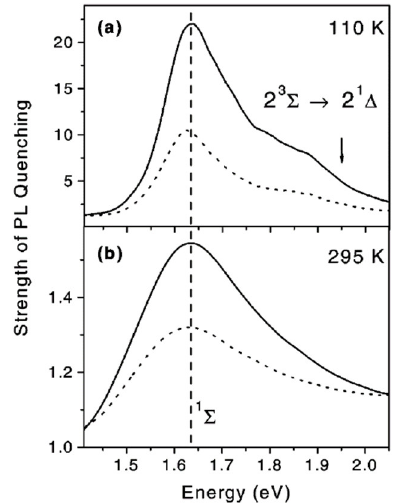
Figure 26. ( a ) Spectra of the PL quenching strength in por-Si with adsorbed O 2 molecules at T = 110 K, 100 mbar (solid line) and 2 mbar (dotted line). ( b ) the same spectra at T = 295 K, 1 bar (solid line) and 100 mbar (dotted line). (From Reference [65]).